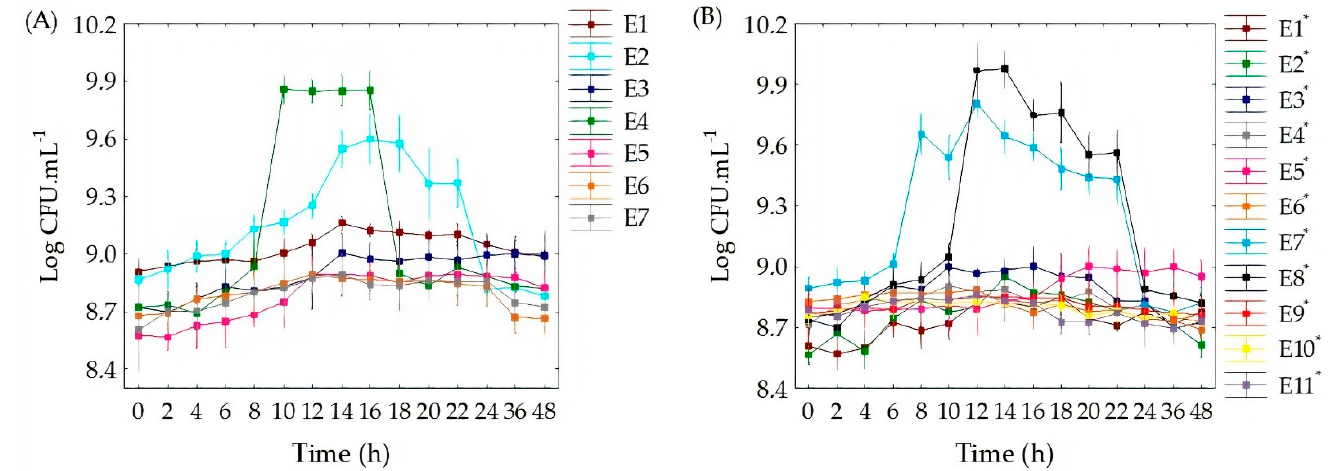
Figure 1. The concentration of L. gasseri cells during fermentation in passion fruit ( A ) fruit added with green tea ( B ). * Test using passion fruit added with green and passion fruit added with green tea ( B ). * Test using passion fruit added with green tea.